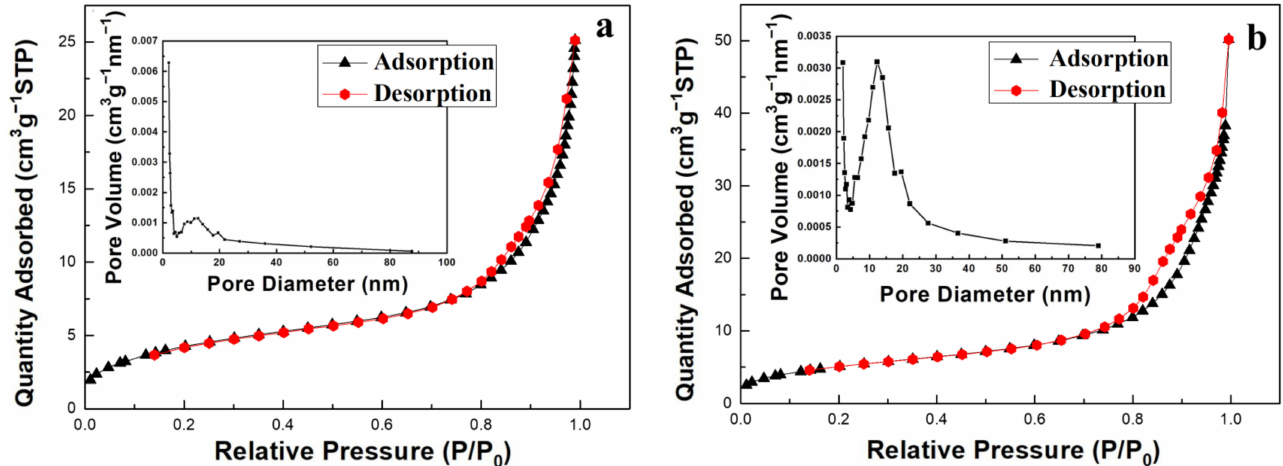
Figure 9. ( a ) N 2 adsorption–desorption isotherm curves of SiO 2 . Inset is Barret Joyner Halenda (BJH) pore size distribution of SiO 2 ; ( b ) N 2 adsorption–desorption isotherm curves of TiO 2 -SiO 2 . Inset is BJH pore size distribution of TiO 2 - SiO 2